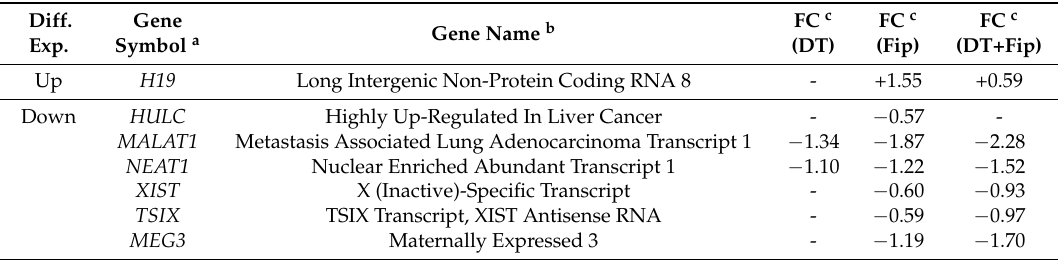
Table 3. Subset of well-studied lncRNAs whose transcripts were significantly ( p ≤ 0.01) differentially expressed (Diff. Exp.; up (+) or down ( − ) regulated) in primary human hepatocytes after exposure